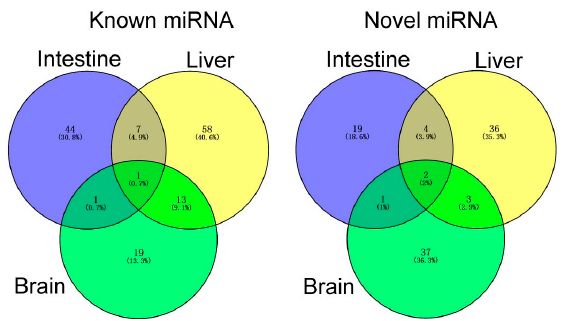
Figure 3. Venn chart of differentially expressed miRNAs M. amblycephala.